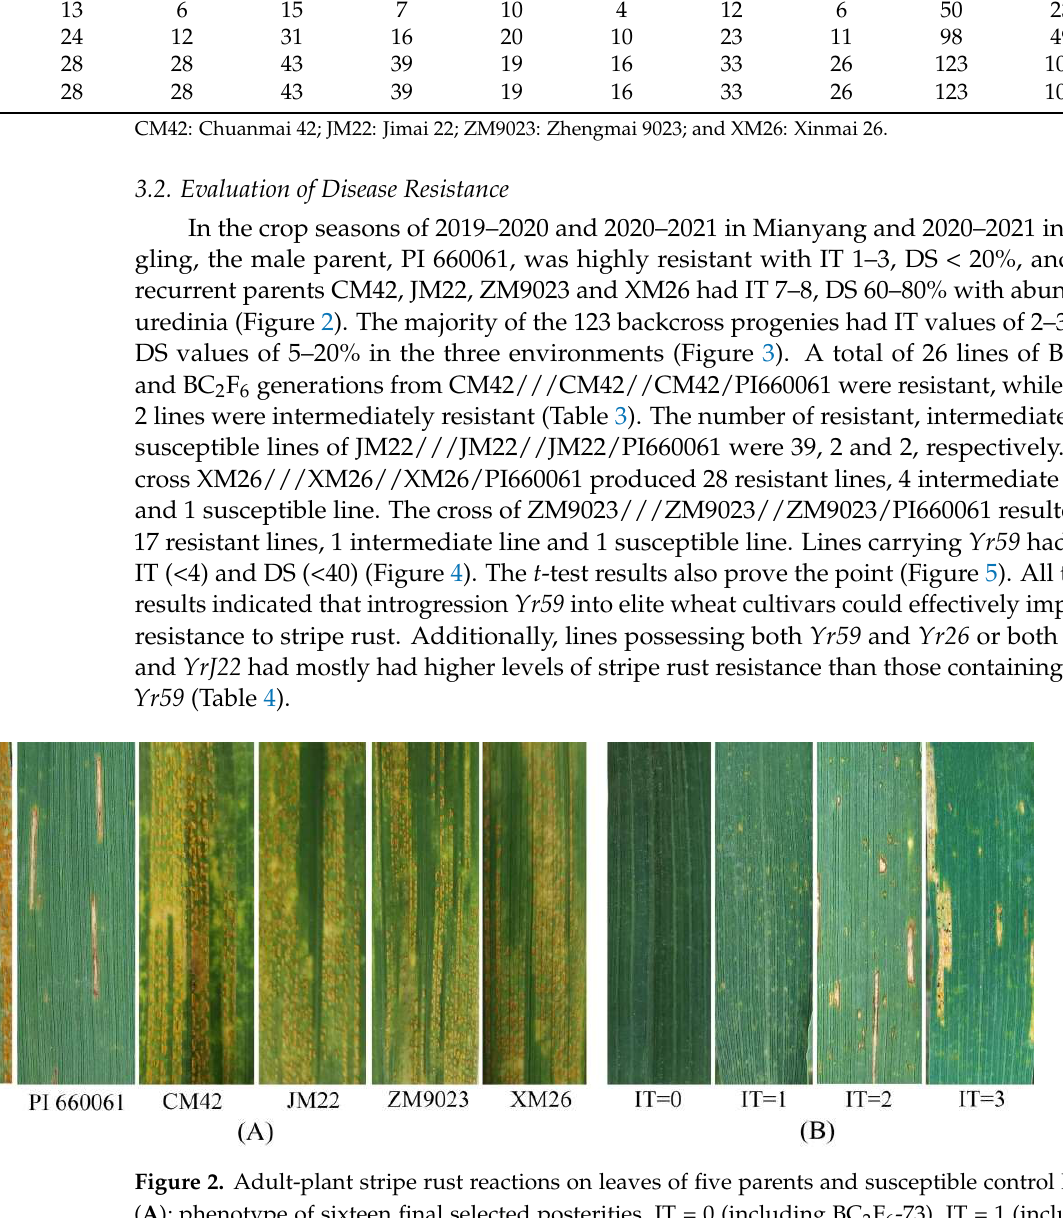
Figure 1. The scheme of introgressing stripe rust resistance gene Yr59 into four elite wheat cultivars through marker-assisted backcrossing (MABC). The Yr59 linkage map was adopted from Zhou et al. (2014). The marker with two asterisks (**) was used in genotyping F 1 , BC 1 F 1 and BC 2 F 1 plants, and the markers with one (*) and two asterisks (**) were used to screen the BC 2 F 5 and BC 2 F 6 lines.